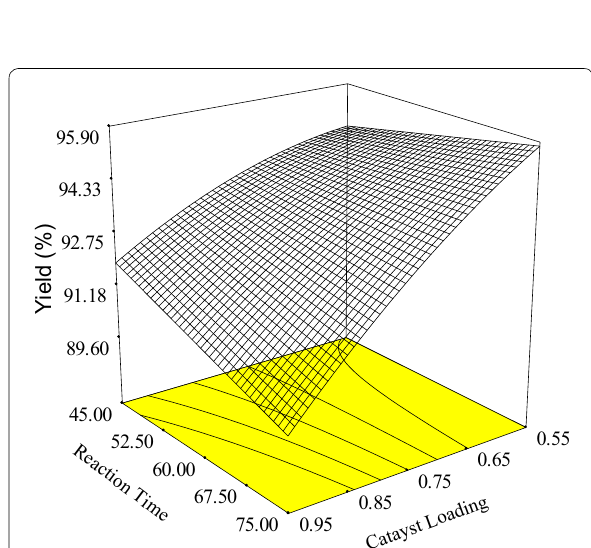
Fig. 6 3D plot of the effects of catalyst loading and time to FAME yield